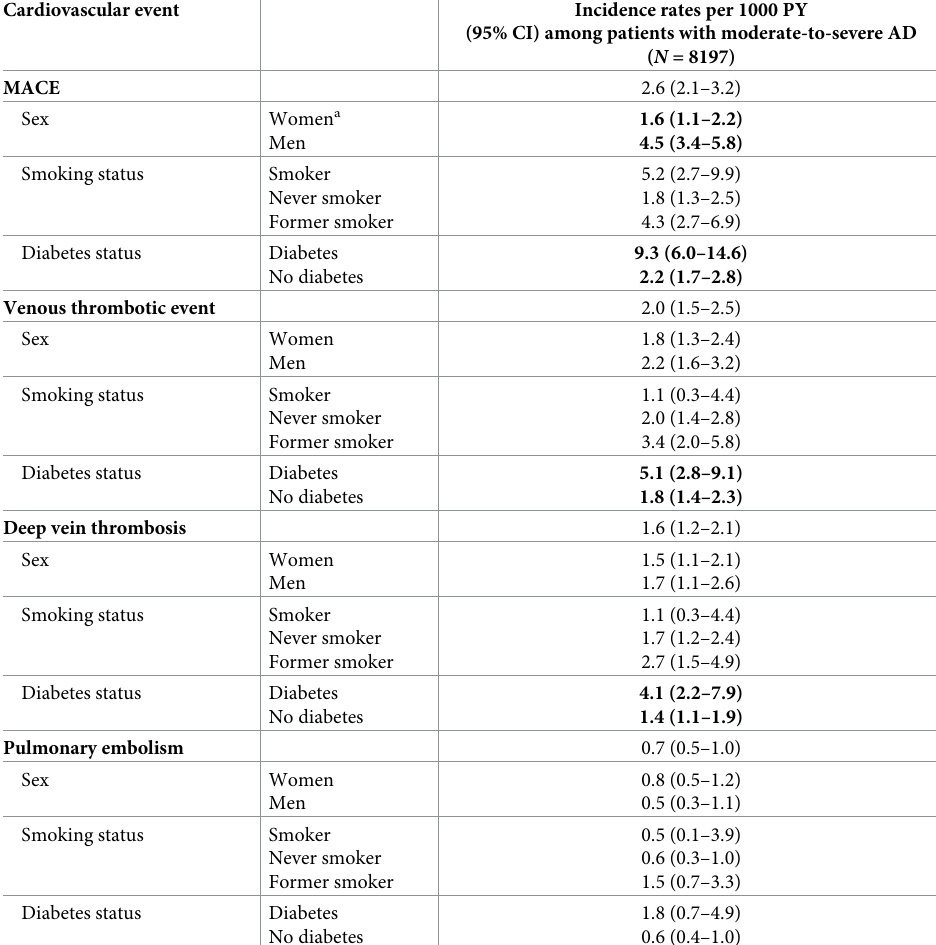
Table 2. Incidence rates per 1000 person-years of cardiovascular events in the cohort of KPNC health plan mem- bers (2007–2018) aged � 12 years with moderate-to-severe AD by sex, smoking status, and diabetes